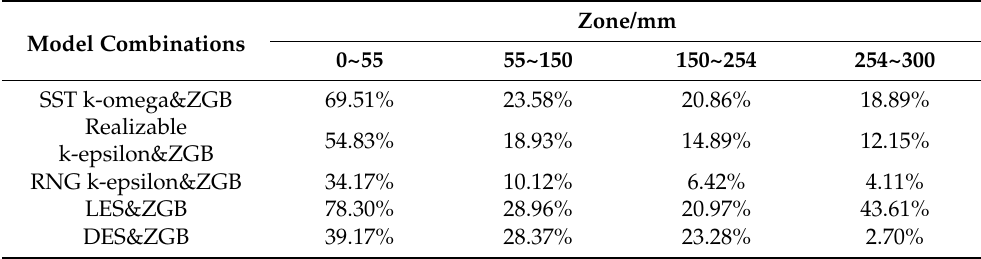
Figure 8. Comparison of flow velocity distribution in microchannel cross-section under different turbulence models. ( a ) The schematic diagram of the location of the two cross-sections within the microchannel; ( b ) Velocity distribution of section x 1 in 55 bar Δ P; ( c ) Velocity distribution of section x 1 in 67 bar Δ P; ( d ) Velocity distribution of section x 2 in 55 bar Δ P; ( e ) Velocity distribution of section x 2 in 67 bar Δ P. Table 7. The error of average cross-sectional x 2 flow rate at 55 bar differential pressure compared to test